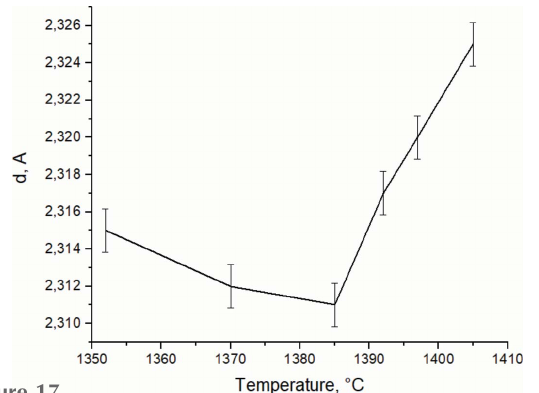
Figure 17 In situ variation in the interplanar distances of TiAl (111) with temperature during the annealing time.